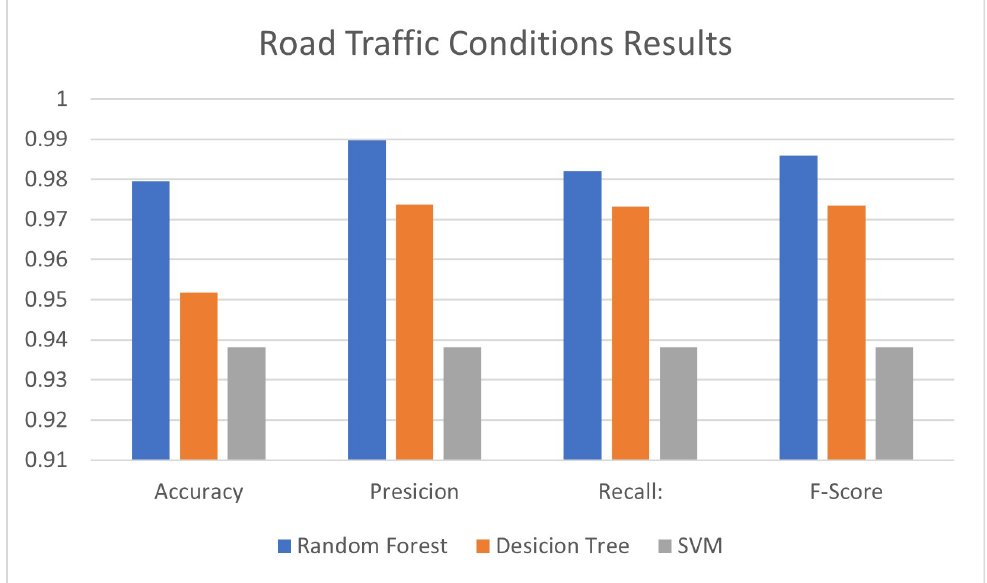
Figure 4. Accuracy, precision, recall and F-score for road traffic conditions results.